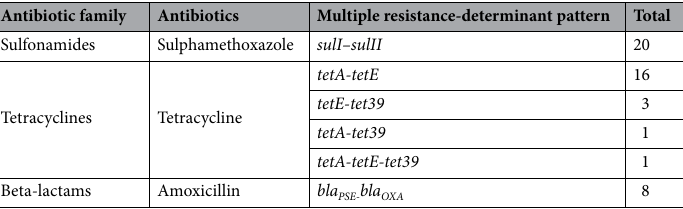
Table 3. Patterns of MAR-Determinants of Vibrio isolates.